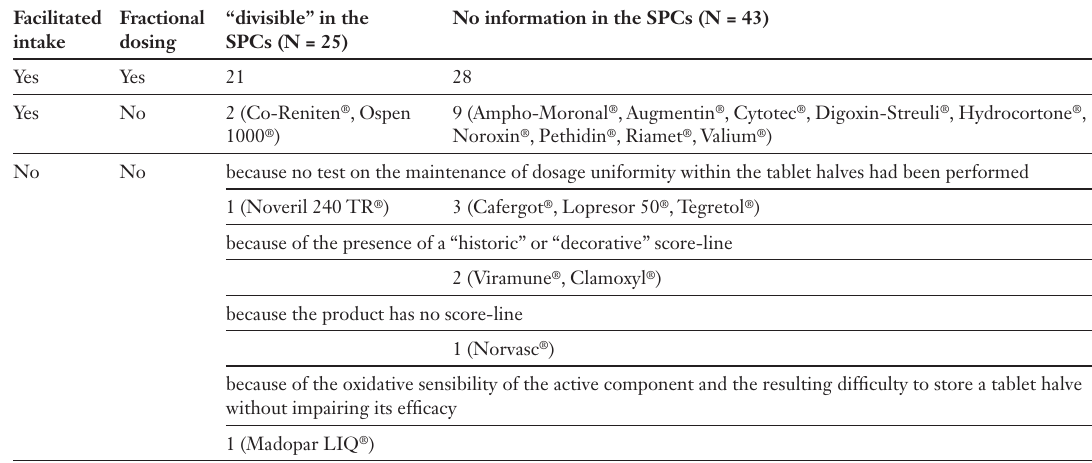
Facilitated intake